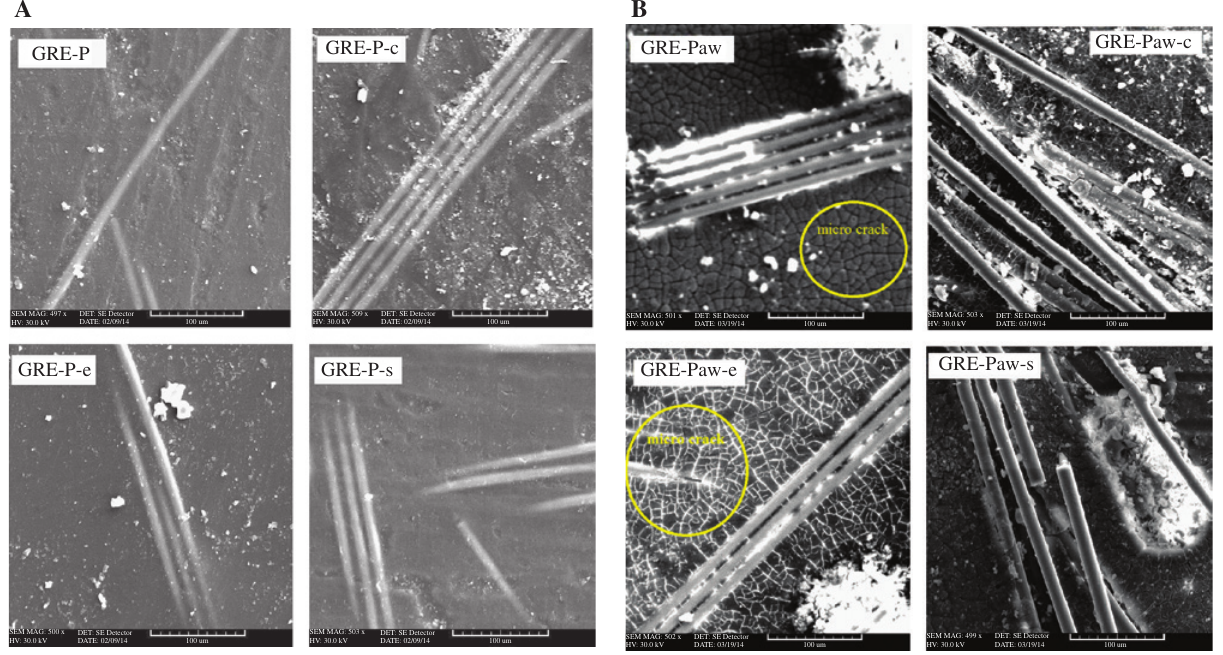
Figure 2: (A) SEM images of the GRE-P control sample and aged samples in wet crude, effluent water and scale inhibitor for 60 days. (B) SEM images of GRE-P samples subjected to accelerated weathering, followed by chemical aging in wet crude, effluent water and scale inhibitor for 60